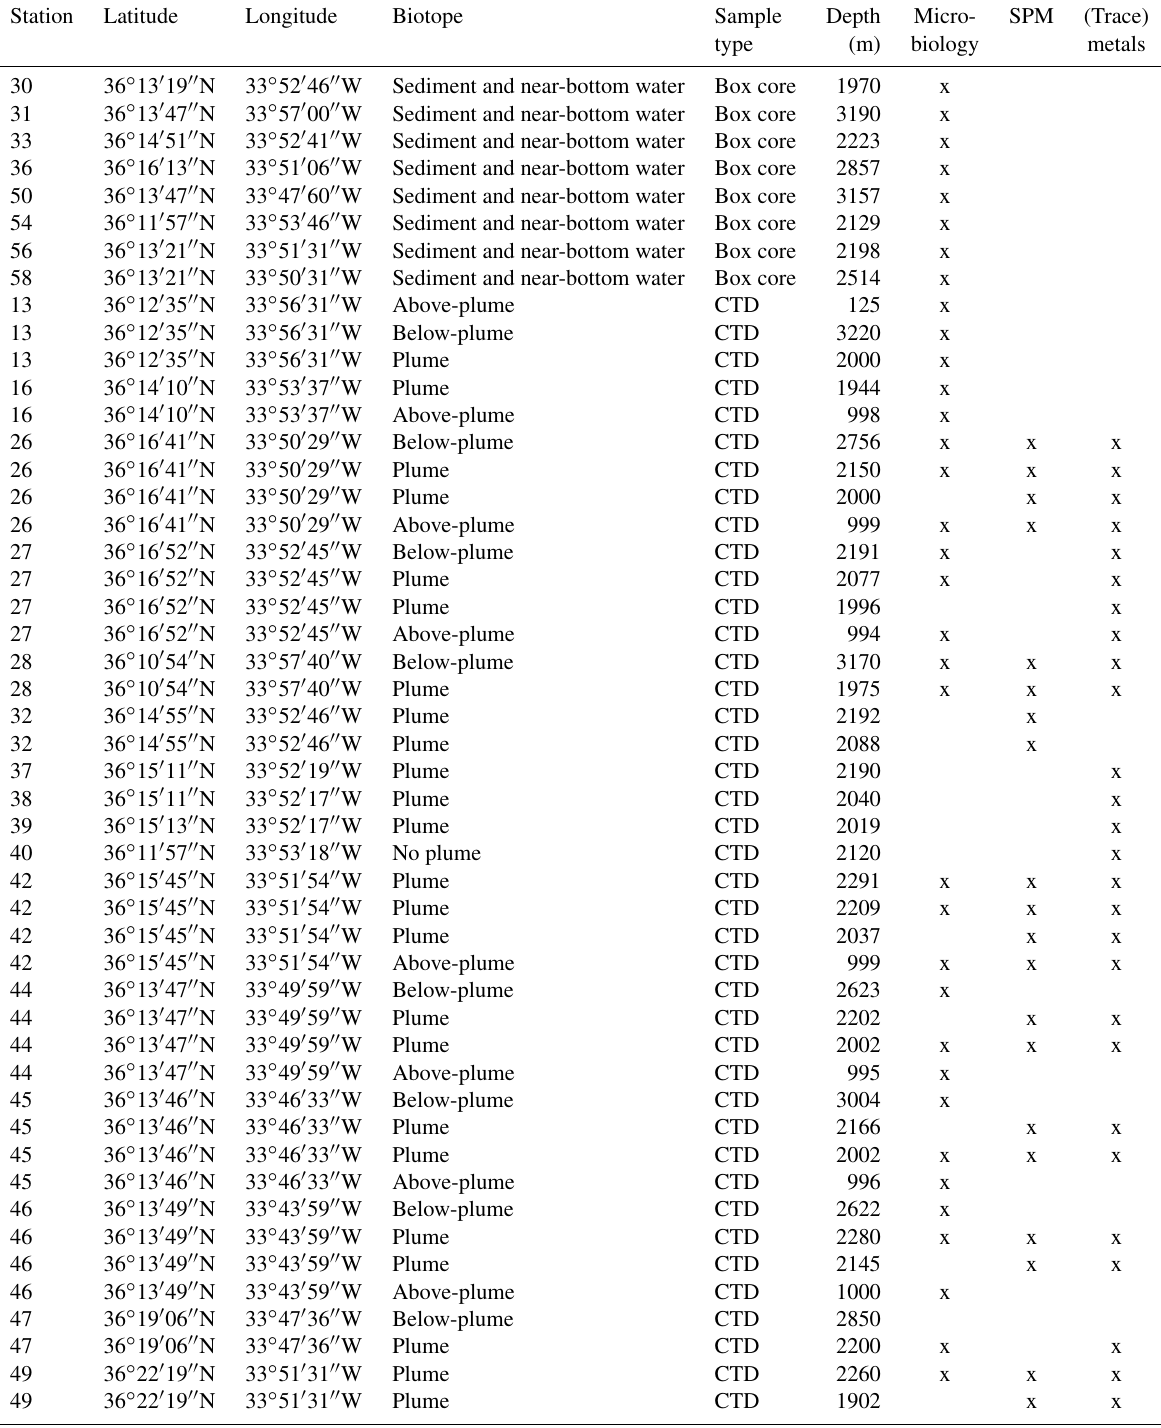
Table 1. Metadata of samples